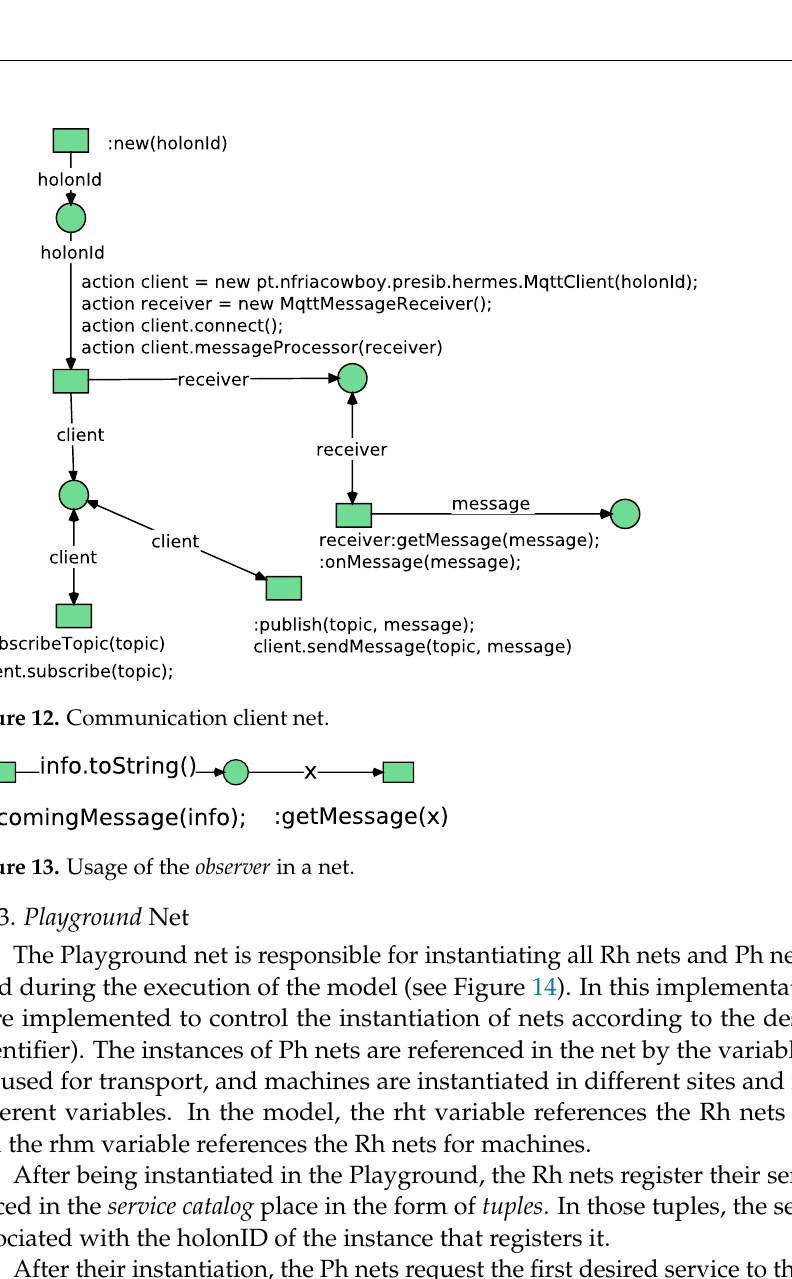
Figure 13. Usage of the observer in a Net